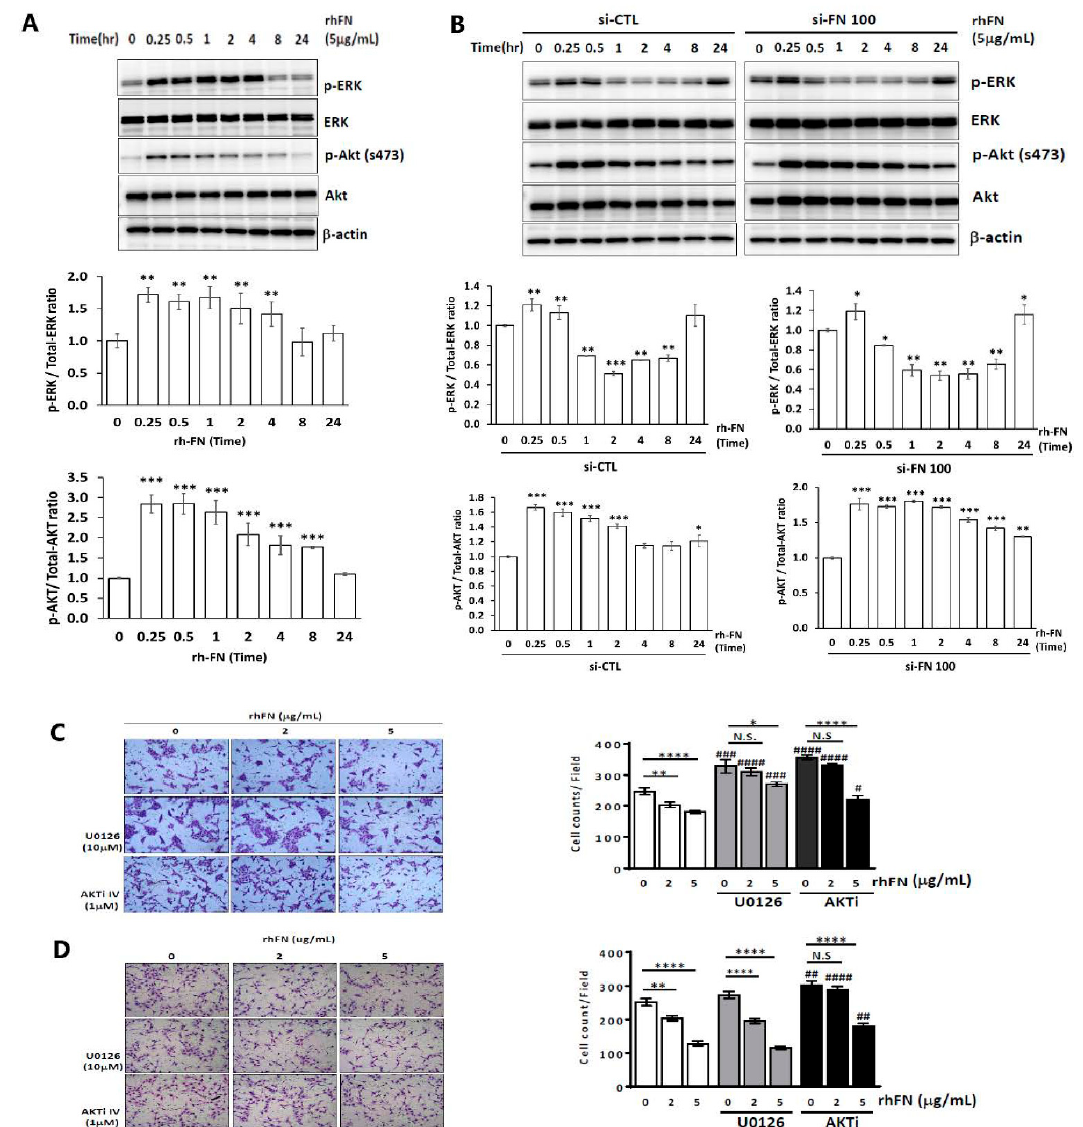
Figure 3. Fibronectin (FN) regulates trophoblast invasiveness and migration by activating ERK and Akt signaling. Phospho-ERK, ERK, phospho-Akt, and Akt were analyzed at different timepoints (0, 0.25, 0.5, 1, 2, 4, 8, and 24 h) after cells were treated with rhFN (5 μ g/mL) using Western blotting and quantification of Western blotting in ( A ) HTR-8/SV neo and ( B ) FN-knockdown cells. ( C , D ) HTR- 8/SVnel cells were pretreated with rhFN (5 μ g/mL) for 24 h and then U0126 (10 μ M) or Akt inhibitor (1 μ M) for another 4 h before ( C ) cell migration and ( D ) cell invasion assays. Data are presented as the means ± SEMs. N.S. denotes no significance, * p < 0.05, ** p < 0.01, *** p < 0.005, **** p < 0.001 compared with the control treated with the same inhibitor. # p < 0.05, ## p < 0.01, ### p < 0.005, #### p < 0.001 compared with samples at the same rhFN concentration without ERK treatment or Akt inhibitors. Scale bar: 100 µ